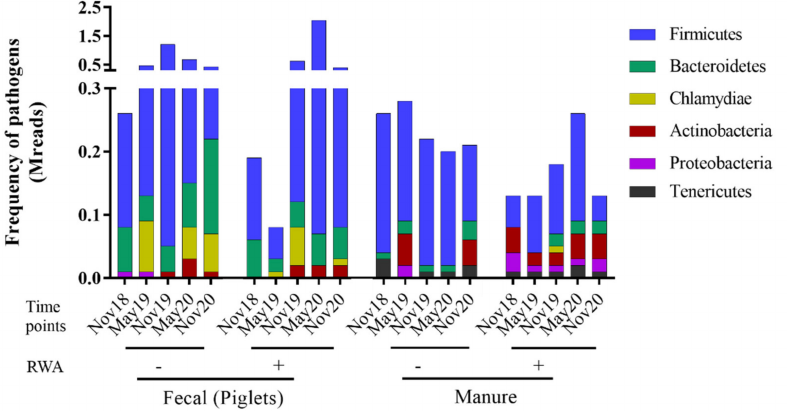
Figure 2. Metagenomic taxonomic profiles at the phylum level from piglet feces and barn manure samples collected from non-RWA − (minus sign) and RWA + (plus sign). The stacked bars represent the averaged frequency of the major bacteriomes from each type of